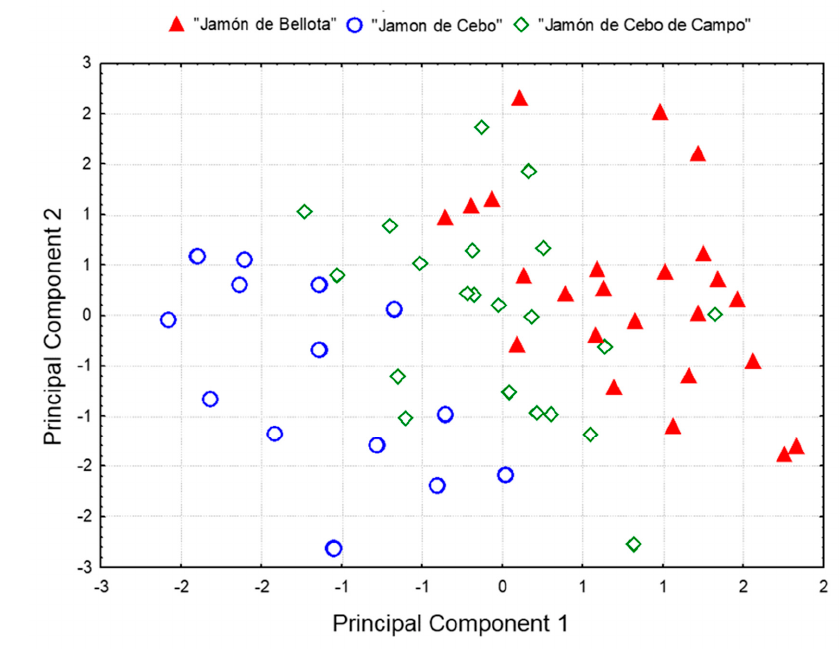
Figure 1. Principal component analysis (PCA) scores plot showing the distribution of samples from the three study groups in the plane defined by the two first principal components.